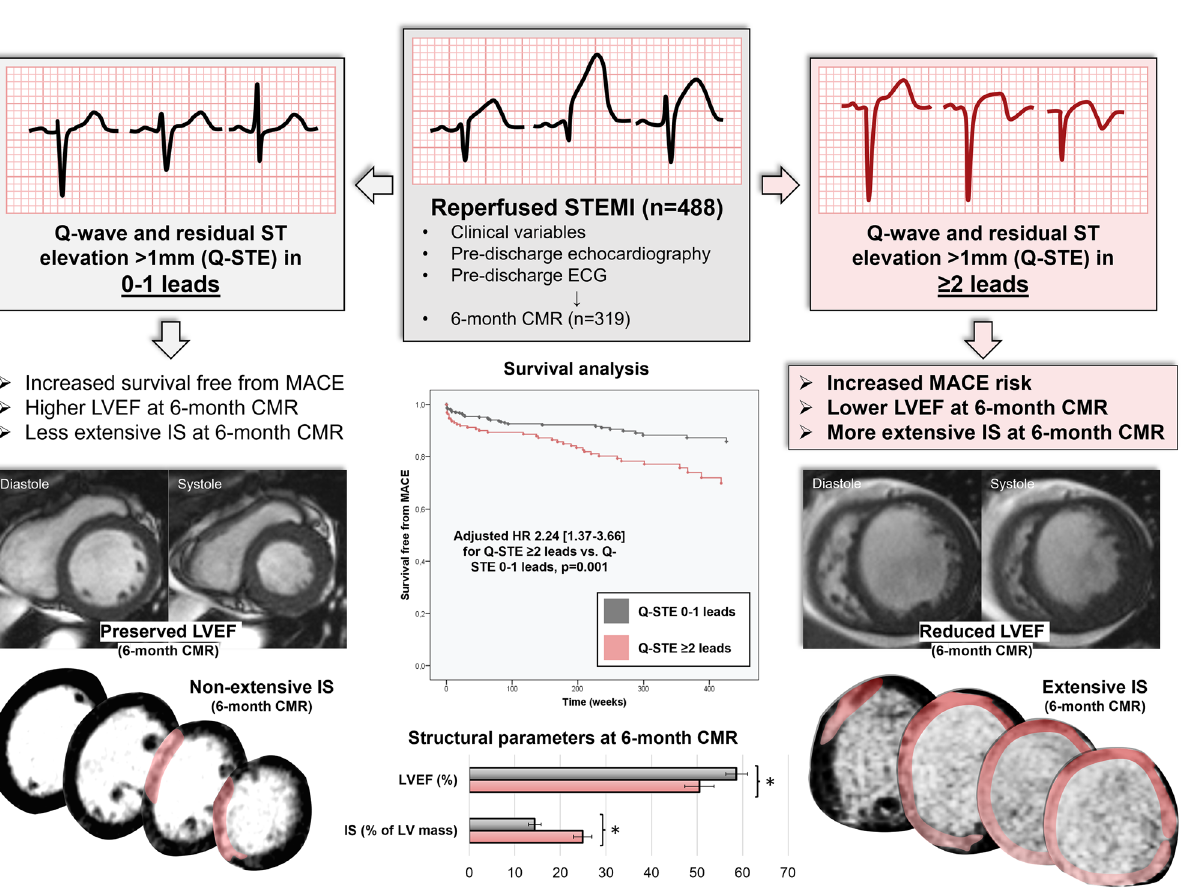
Figure 5. Visual summary depicting the most relevant findings of the study. Abbreviations: CMR = cardiac magnetic resonance. HR = hazard ratio. IS = infarct size. LV = left ventricular. LVEF = left ventricular ejection fraction. STEMI = ST-segment elevation myocardial infarction. Q-STE = Q wave and residual STE > 1